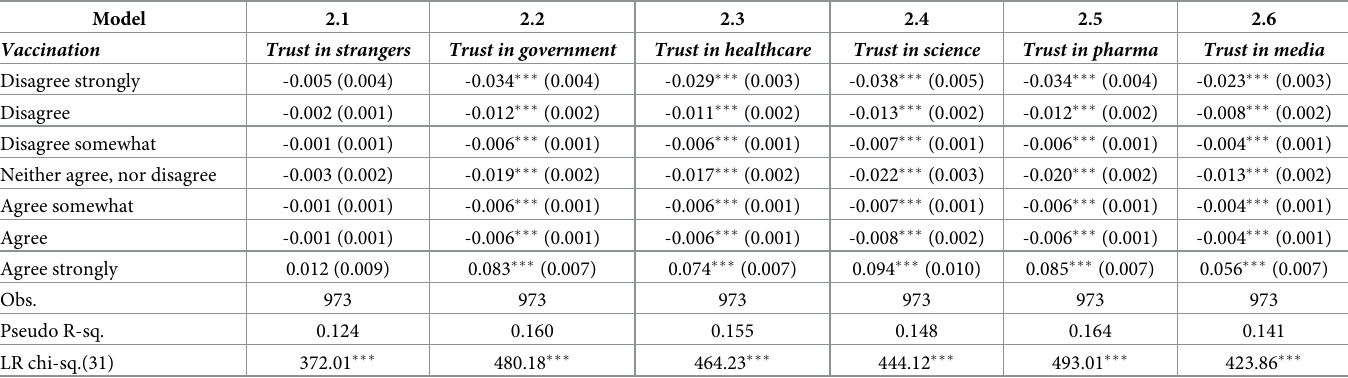
Table 2. Ordered logistic regression model with single trust variable and all